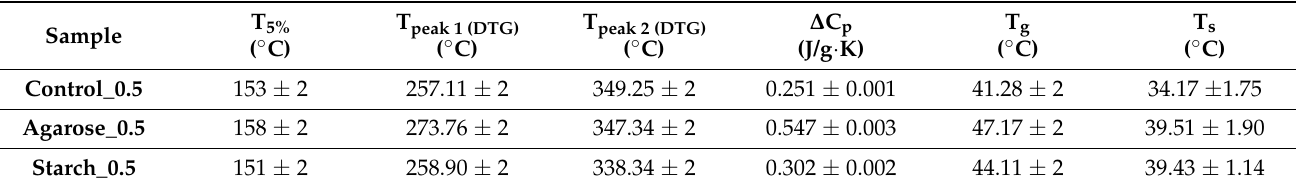
Table 3. Thermal properties of samples.